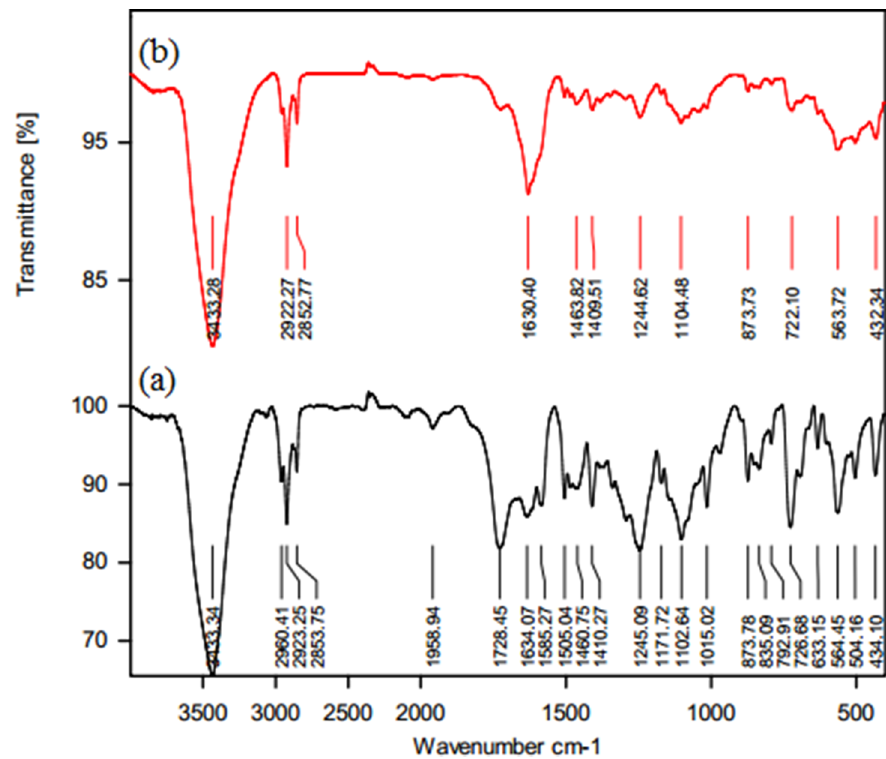
Figure 1. Fourier-transform infrared spectroscopy (FTIR) spectra of NF-3 membranes: before use ( a ); soaked for 2 months in a 45 wt. % methyl diethanolamine (MDEA) solution ( b ).